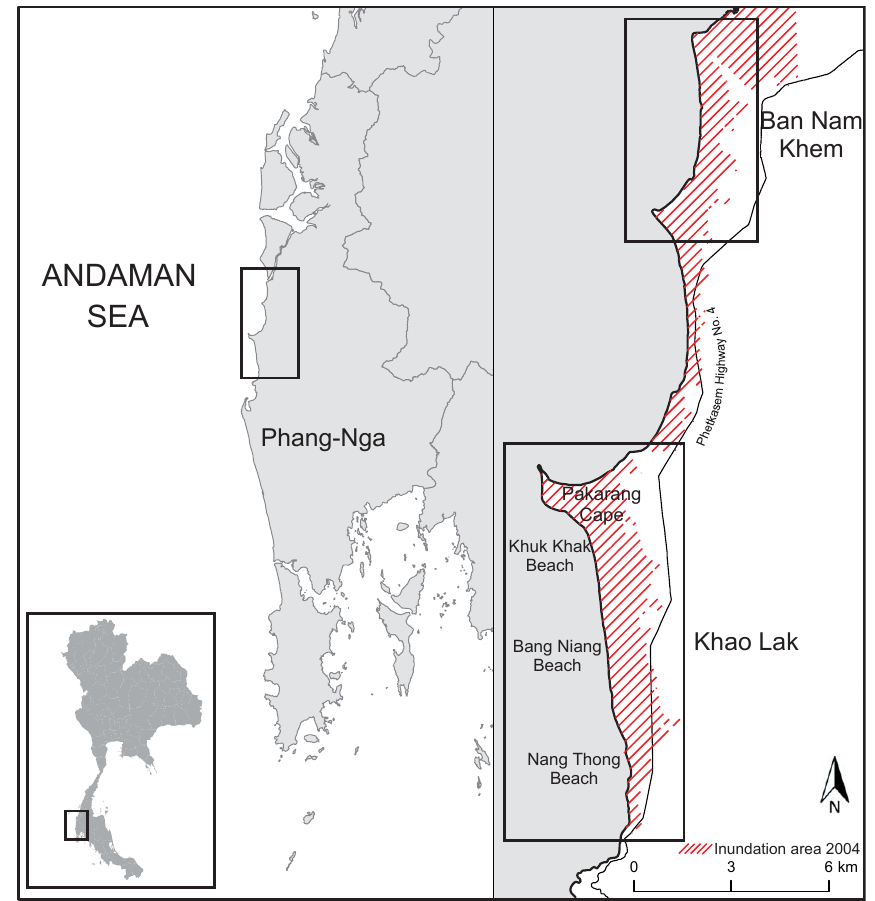
Fig. 3. Location of Ban Nam Khem and Khao Lak and the tsunami inundation